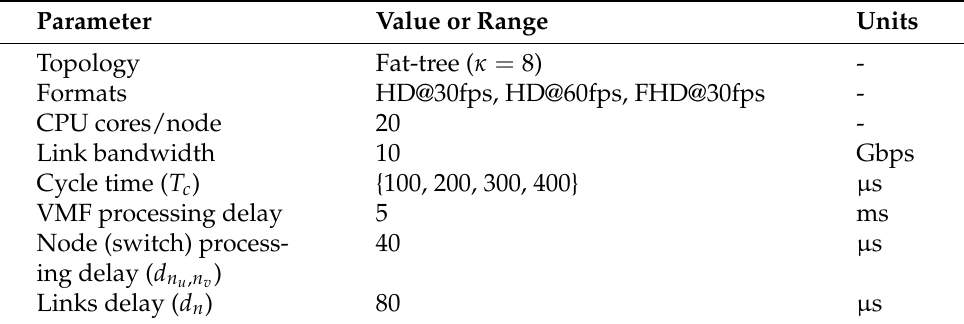
Table 2. Default values/range of various parameters involved in the evaluation.